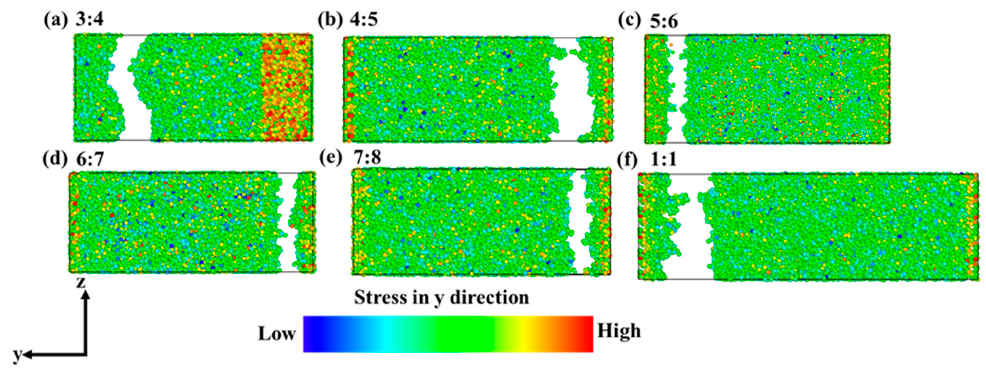
Figure 11. The cross-sections of SiN x in the tensile tests. ( a ) x = 4/3, ( b ) x =5/4, ( c ) x = 6/5, ( d ) x = 7/6, ( e ) x = 8/7, ( f ) x = 1/1.